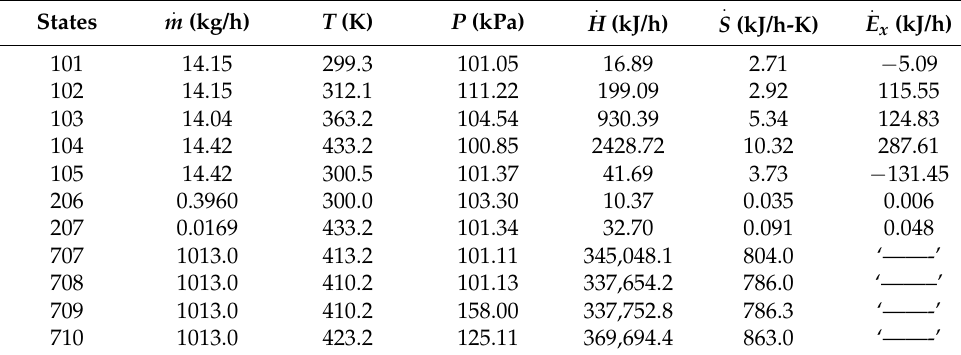
Figure 1. Schematic of 5-kW high temperature PEMFC system. Table 1. Property values and thermal, and mechanical exergy flows and entropy flow rates at various state points in hydrogen-fueled 5-kW PEMFC.